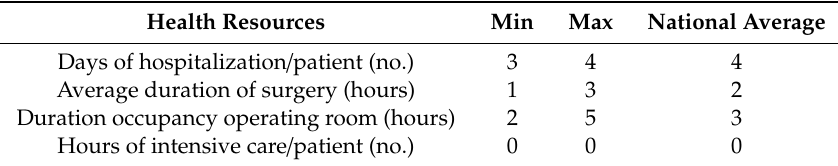
Table 3. Consumption of health resources in VNS implantation